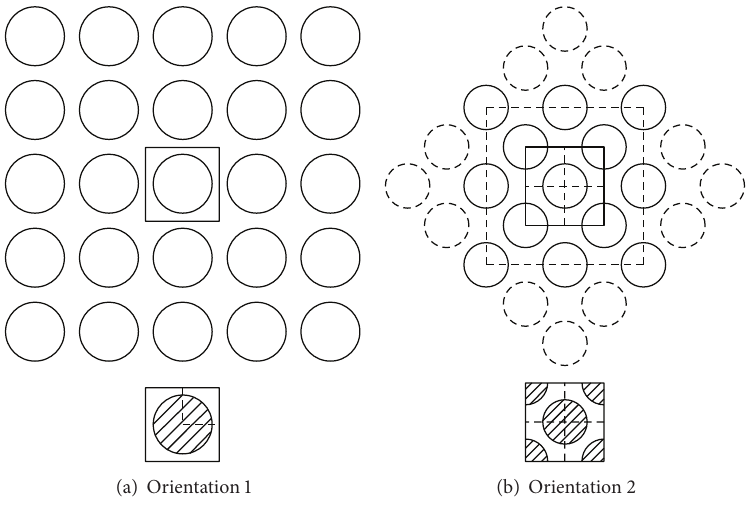
Figure 4: Unit cells with two orientations ( 𝑉 𝑓 = 0.5 ).